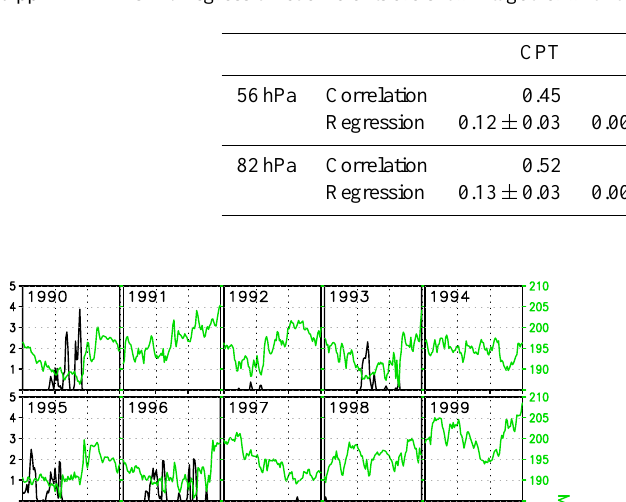
Table 1. Coefficients of correlation and regression. The units for the regression coefficients are ppmvK − 1 for CPT, ppmvm − 1 s − 1 for QBO, and ppmvmm − 1 s − 1 . Regression coefficients are shown together with the 95% confidence intervals.